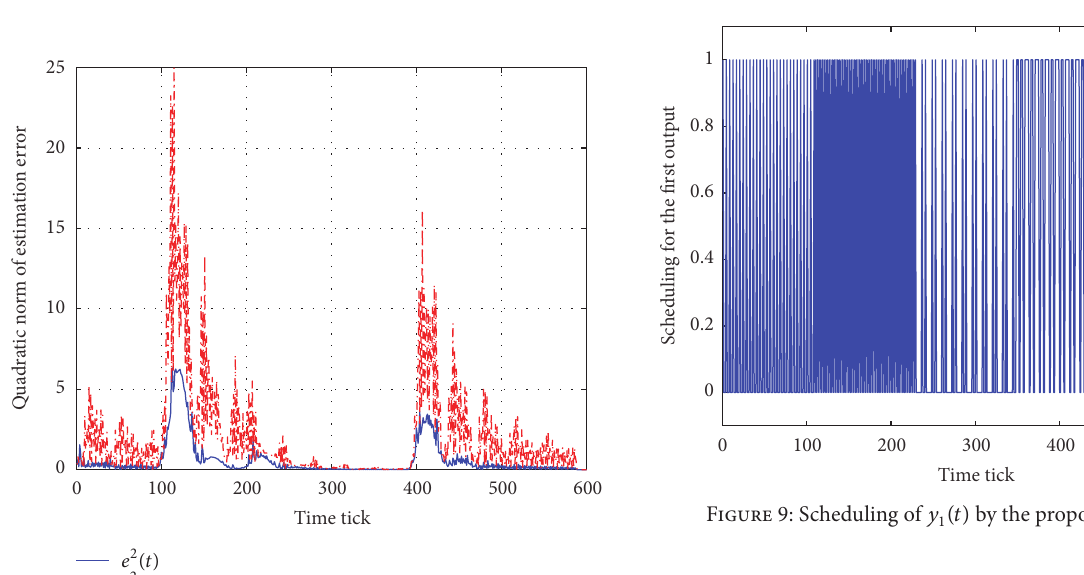
Figure 6: Estimation errors for the proposed method with RTZ and ZOH.